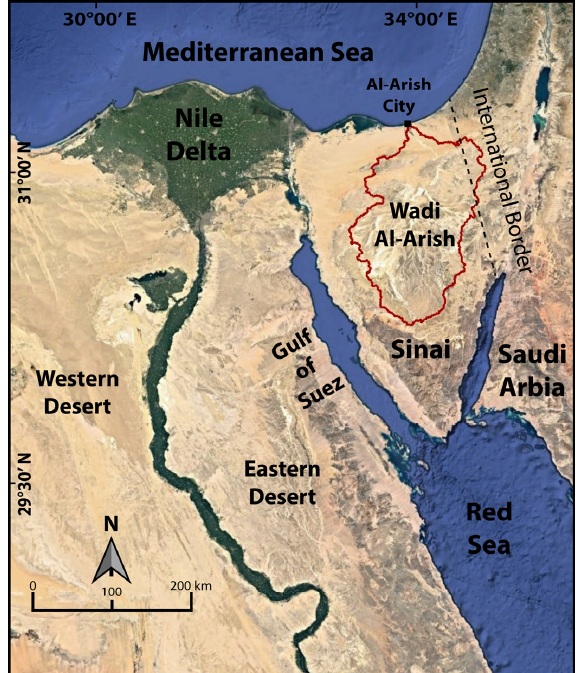
Figure 1. Google earth image of northern Egypt showing landscapes and water bodies. The black dashed thin line indicates the international border. The studied Wadi is shown by a red polygon.